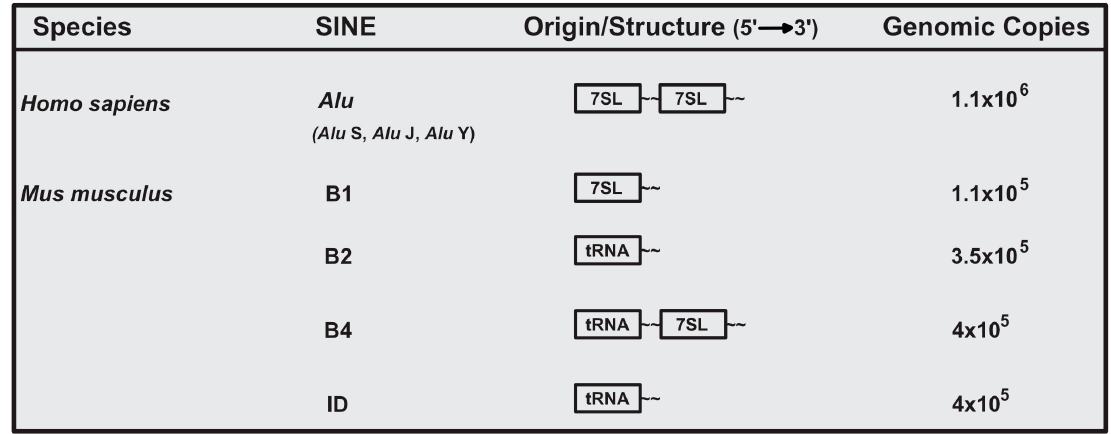
Figure 1. Origin and genomic abundance of major human and murine short interspersed element (SINE) families.